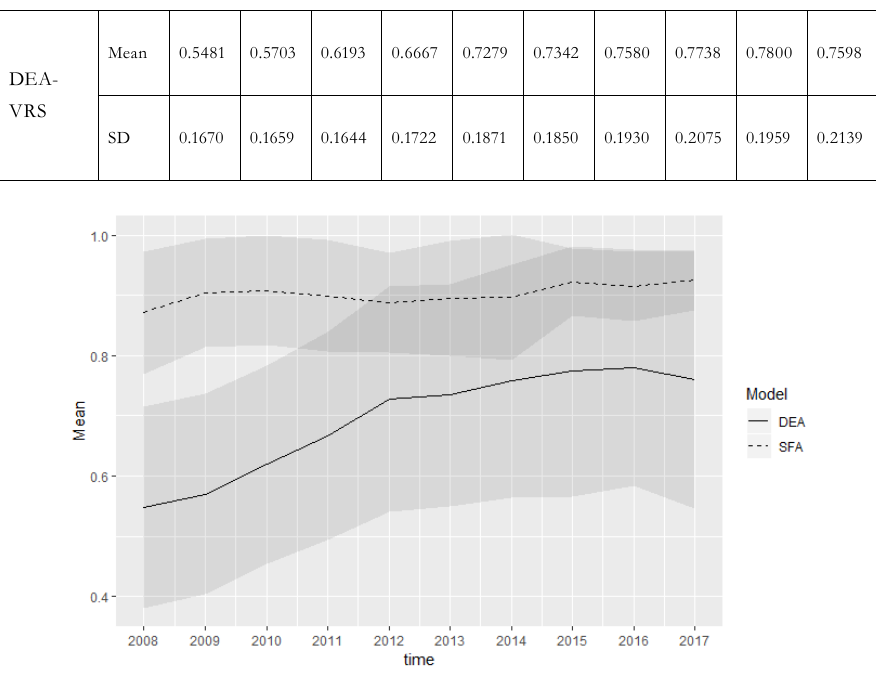
Fig. 2 – Mean and SD of SFA/DEA over time. Source: author’s own. Note: Confidence interval is based on one standard deviation for illustration